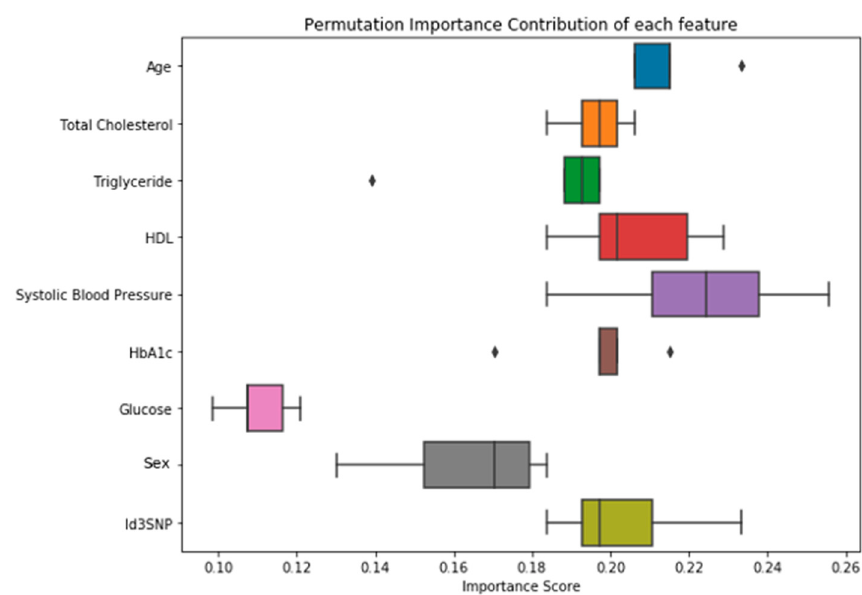
Figure 6. Importance score of each input feature demonstrated with di ff erent color boxplot (with square indicating outliers) on our best machine learning model. Importance score, defined as cross-validation score for model with actual values minus that using permuted values, for each of the 9 most important features where values were permuted 5 times for each feature. Age, total cholesterol, triglyceride, HDL, systolic blood pressure, HbA1c, glucose, sex, and Id3SNP are the 9 most important features out of 13 features chosen as inputs of our model input features. These 9 inputs contribute at di ff erent levels in enhancing precision and accuracy of the model with systolic blood pressure, HDL and age being the top 3 most important